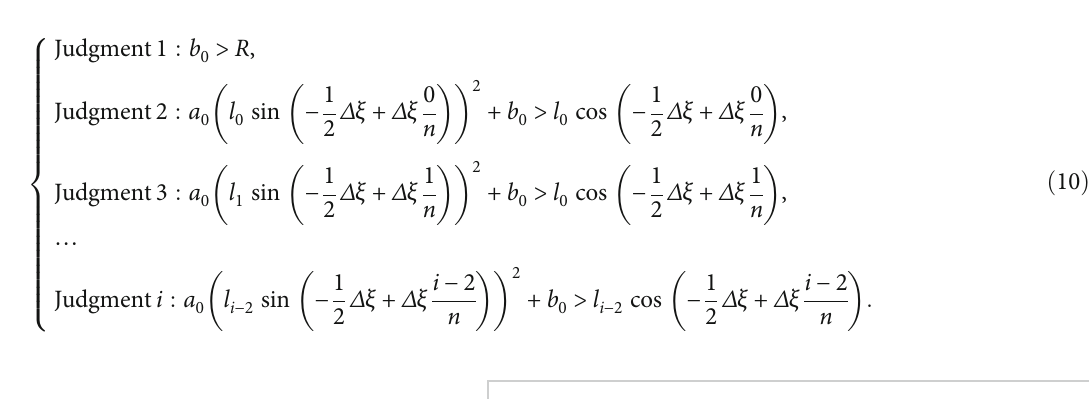
adjustment strategies for the three parameters are shown in Figure 6. 4.2. Relational Mapping of Deep Neural Networks. The rela- tionship between the reachable area boundary parameters and the boost terminal states needs to be mapped to obtain e ff ective boost terminal states. The same reachable area may correspond to multiple sets of boost terminal states.